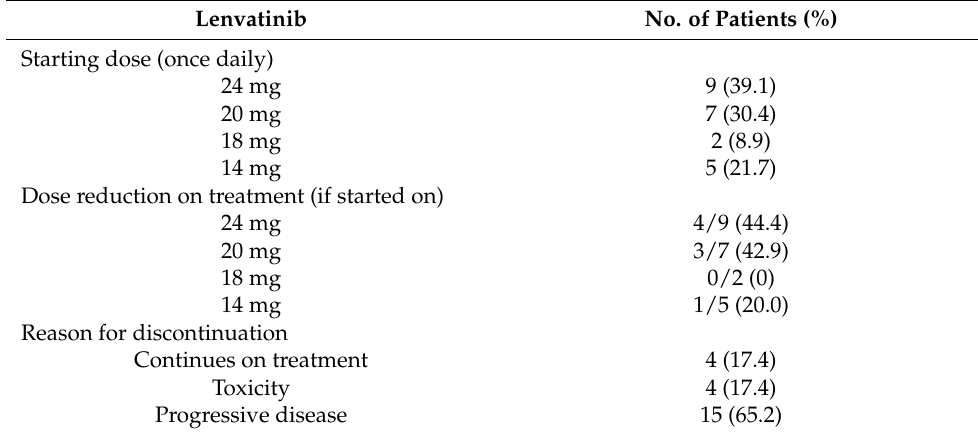
Table 2. Lenvatinib starting dose and dose reduction.